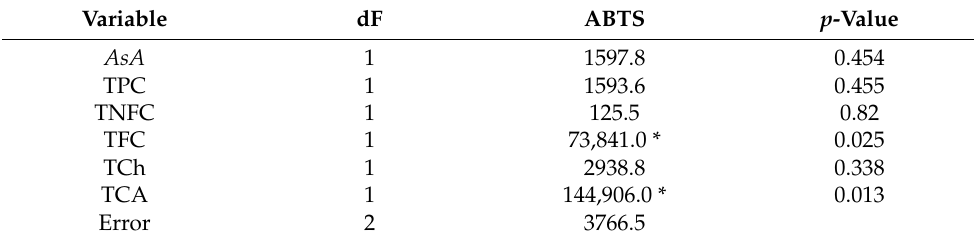
Table 4. Analysis of variance (ANOVA) for FOP model for ABTS calculation.